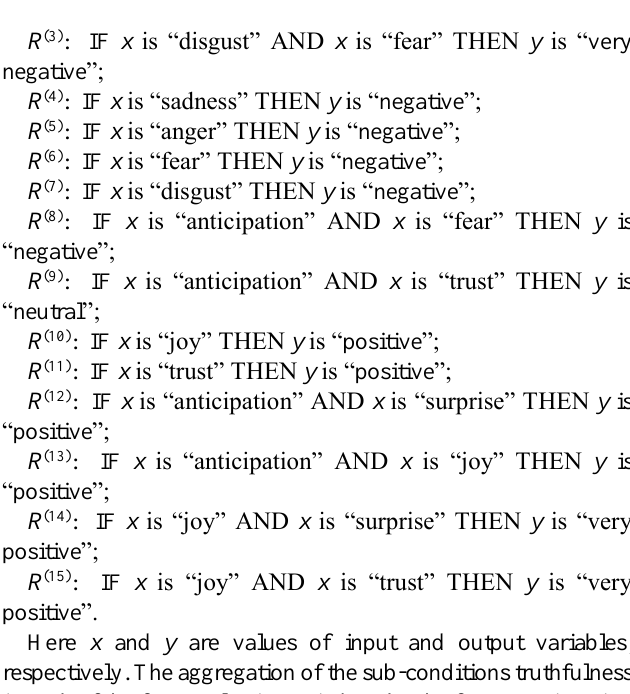
Fig. 2. Membership functions of fuzzy sets characterizing the terms of the output variable “text